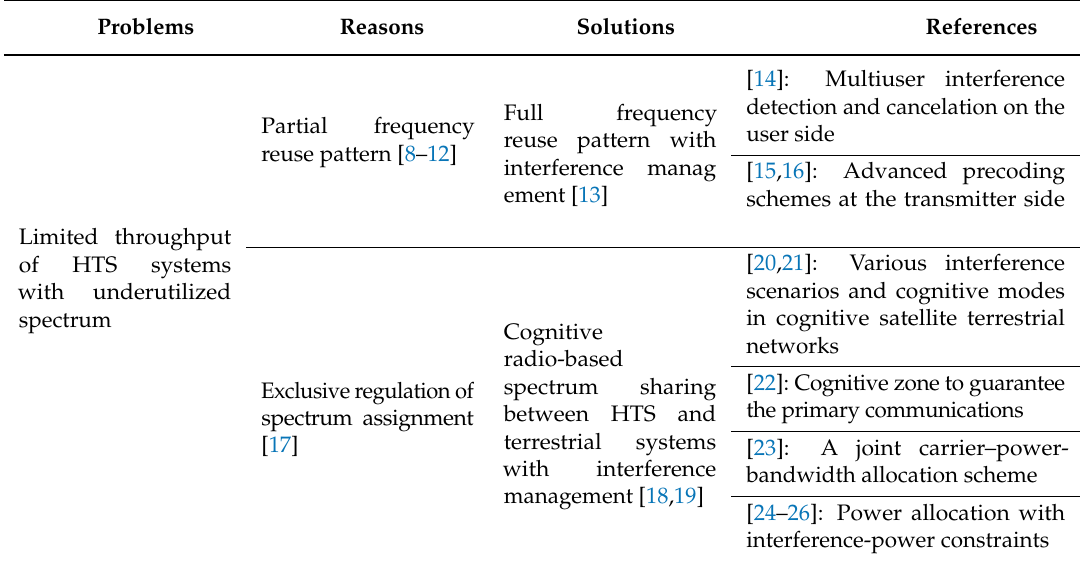
Table 1. The main reasons and the related solutions for limited throughput of high-throughput satellite (HTS)